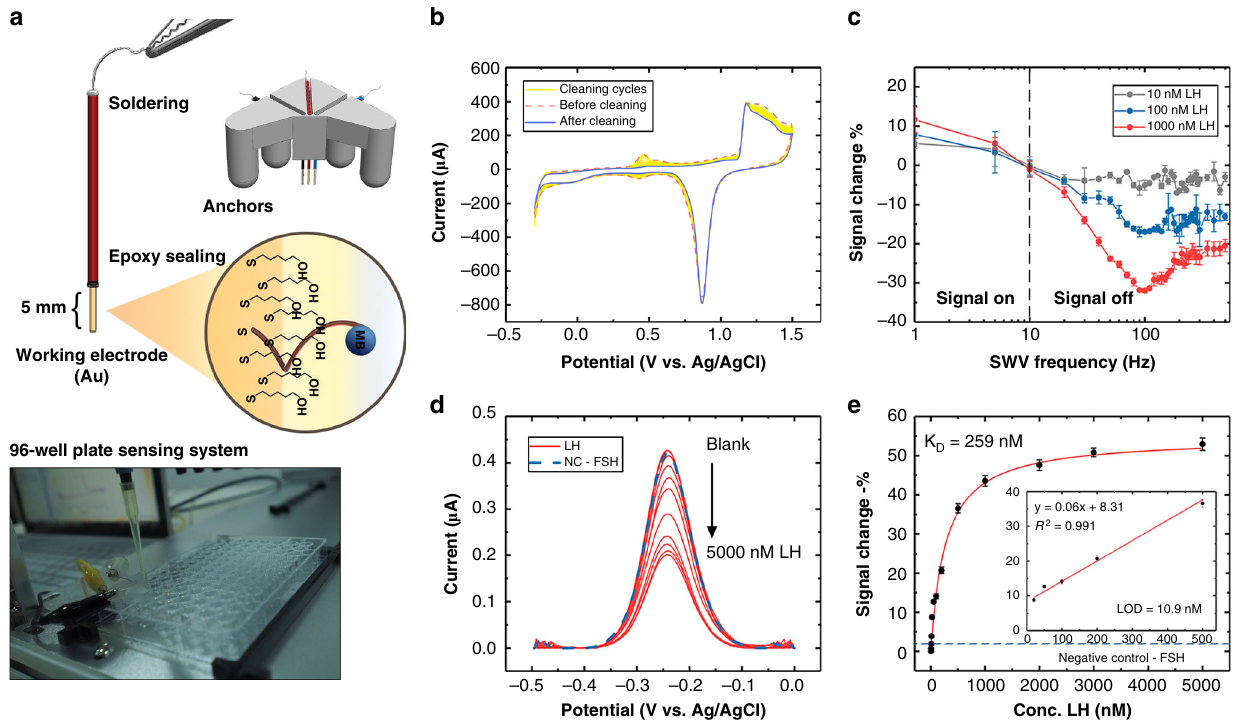
Fig. 3 Characterisation of the wire electrochemical system. a Illustration of the wire electrochemical system. Gold, Ag/AgCl and platinum wires were used as the working, reference and counter electrode, respectively. All the wires were insulated by PVC insulation tape and left two exposed ends for sensing and connecting. All the wires were placed into a 3D-printed holder with anchors that can sit on a single well of a 96-well plate. b Electrochemical cleaning of the wire was performed using CV by repeat scanning from − 0.3 to 1.5 V in 0.5 M sulphuric acid until typical clean gold cyclic voltammograms were observed. c Signal change at different SWV frequencies. MB peak signals of the LH aptamer were recorded under scans in different SWV frequency settings. We applied three concentrations (10, 100 and 1000nM) of LH to investigate the signal change. Means ± s.d. from three independent experiments are shown ( n = 3). d Square-wave voltammogram of wire-based LH aptamer sensor. All the curves were net currents obtained by performing SWV scan from − 0.5 to 0 V, with 100-Hz frequency and 25-mV amplitude. Eight concentrations of LH were used: 0, 10, 50, 100, 200, 500, 1000 and 2000 nM. Error bars represent standard deviation ( n = 3 replicates). e Concentration – response curve. The % of the signal change indicates that the change is a signal off model. The K D was estimated to be 259 nM and the dynamic range was from 10 to 500 nM. Means ± s.d. from three independent experiments are shown ( n = 3). Source data are provided as a Source Data fi